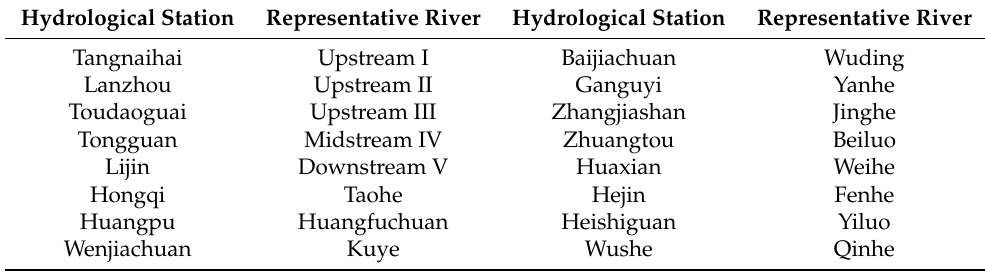
Table 1. Correspondence between hydrological stations and rivers considered in this